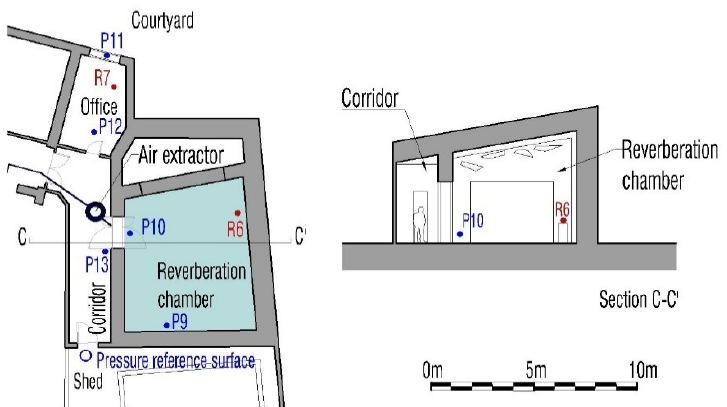
Figure 5. Positions of spaces and sensors. Acoustic wing and reverberation chamber section. Radon sensors (R) are highlighted in red. Pressure sensors (P) are highlighted in blue.